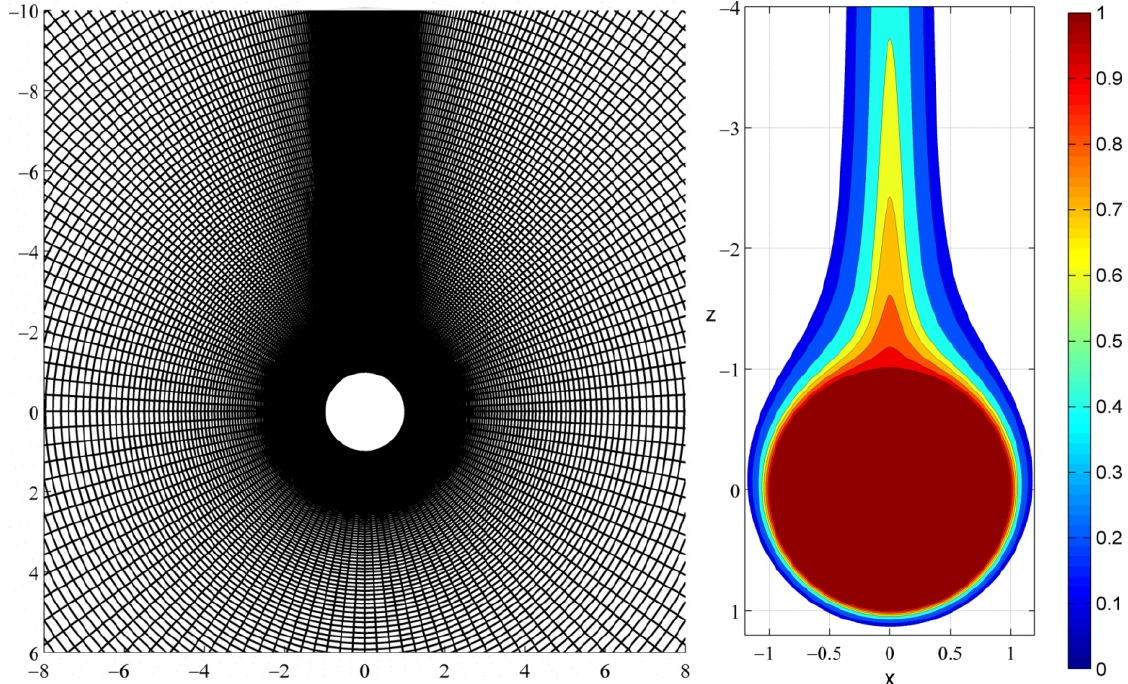
Figure 2. Representative computational grid and detail of the trailing plume for Pe = 1000. The computational grid is dense around and behind the particle so as to capture both the boundary layer and the plume tail with sufficiently high numerical resolution.